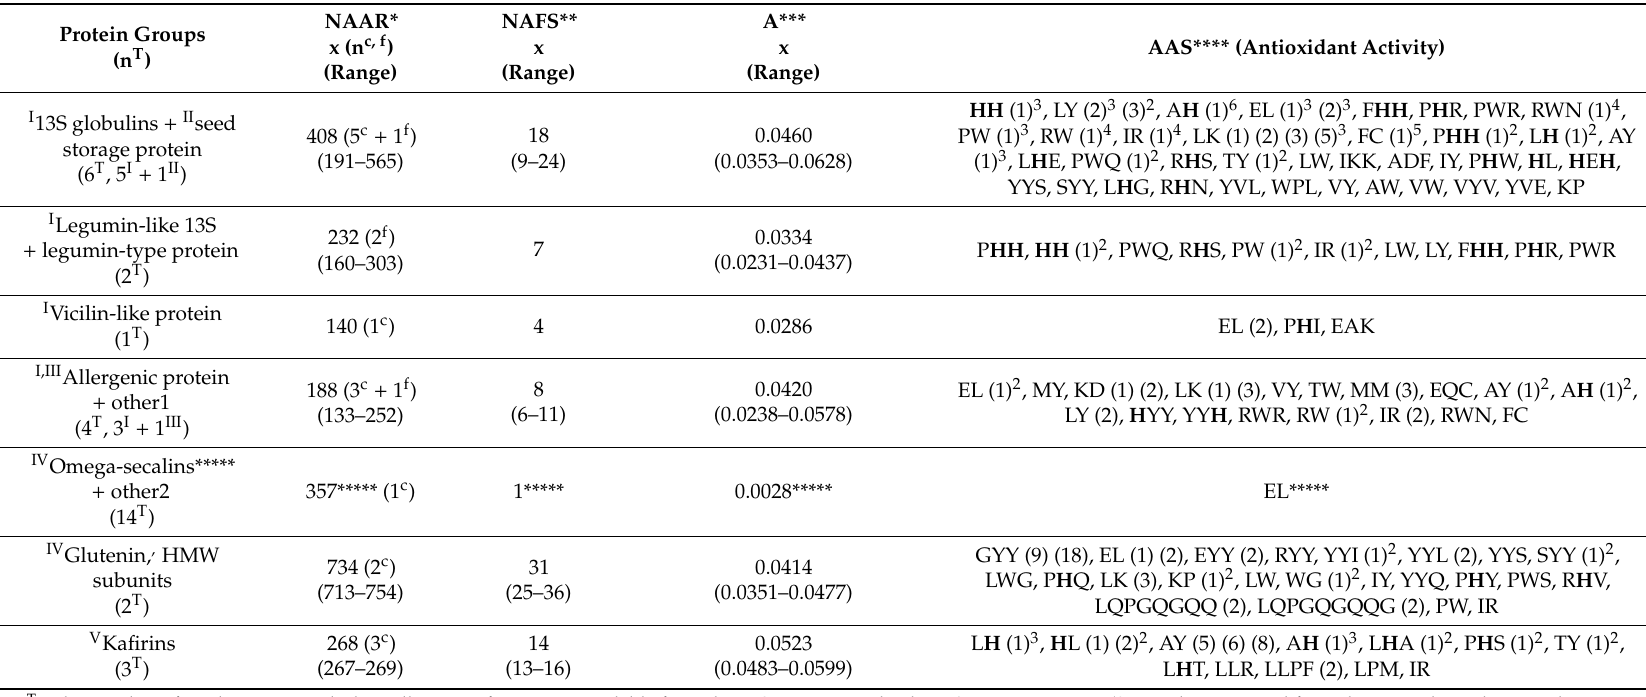
Table 5. Characteristics of buckwheat ( I Fagopyrum esculentum, II Fagopyrum gracilipes, III Fagopyrum tataricum ), rye ( IV Secale cereale ) and sorghum ( V Sorghum vulgare ) proteins antioxidant